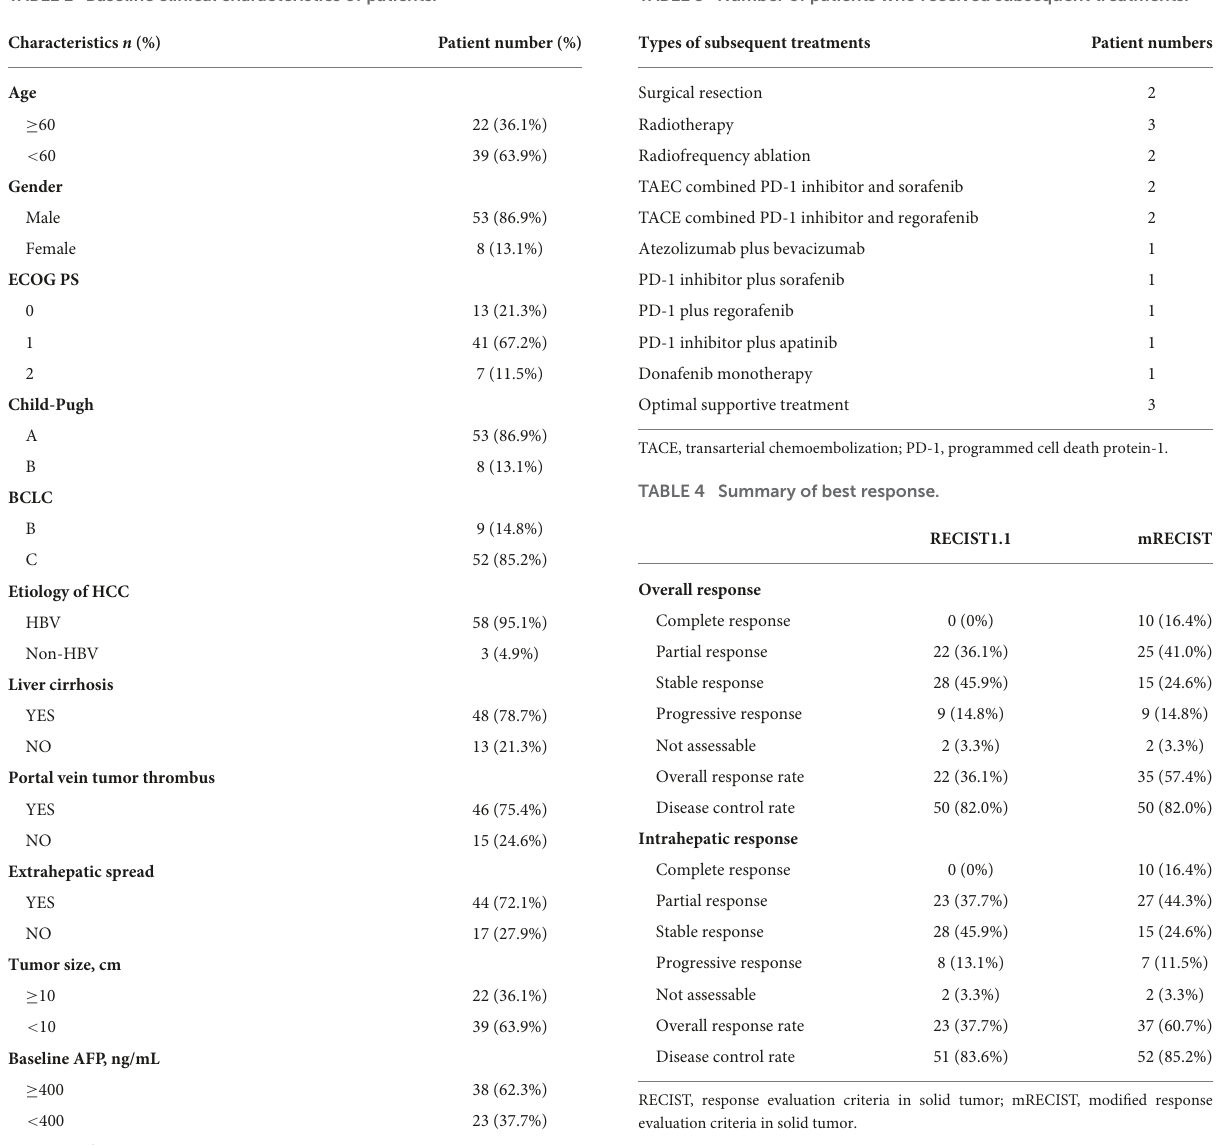
TABLE 1 Baseline clinical characteristics of patients.